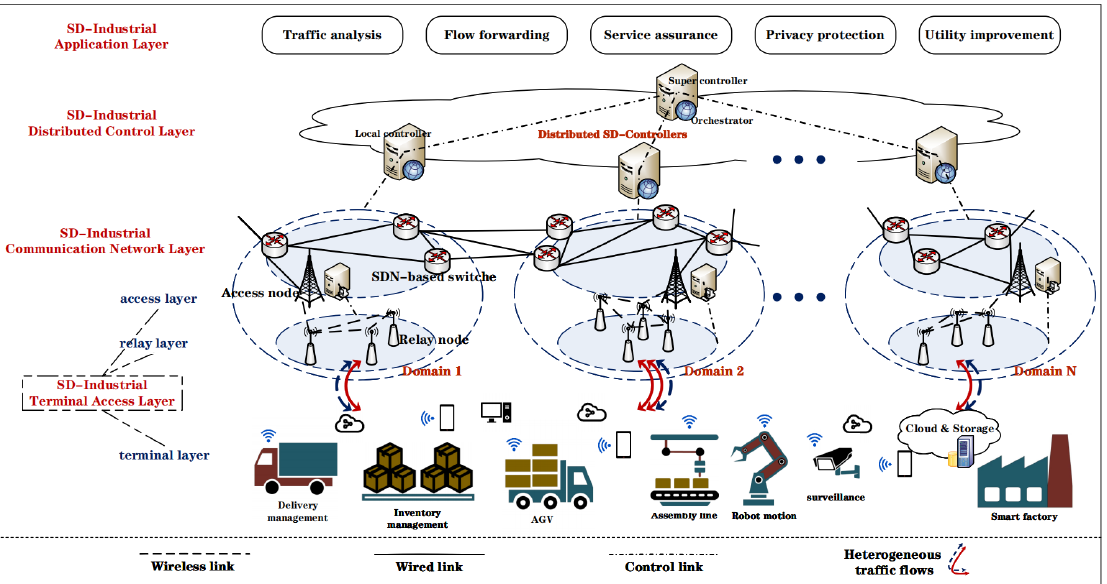
Figure 1. SD-IIoT green architecture supporting cross-domain interconnection of large-scale hetero- geneous